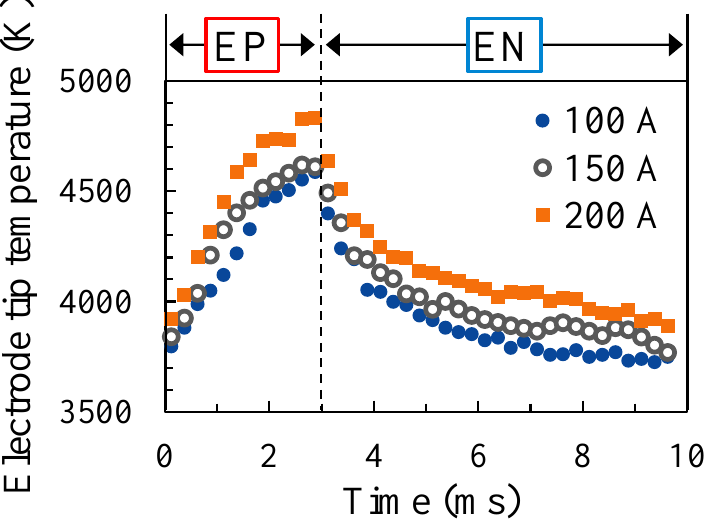
Figure 13. Temperature variation of the electrode tip for different welding currents.